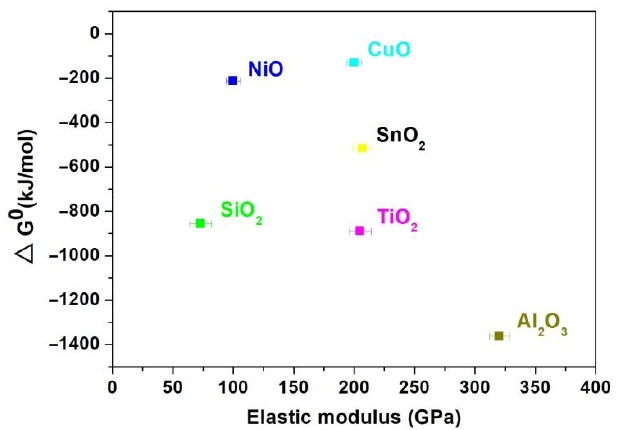
Figure 10. The Gibbs free energy used to form the oxides and elastic modulus of the oxides.